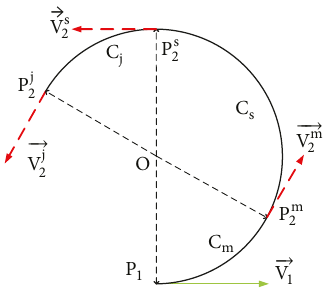
󵱰𝑃 𝑃 𝑠 1 2 , and the major C segment